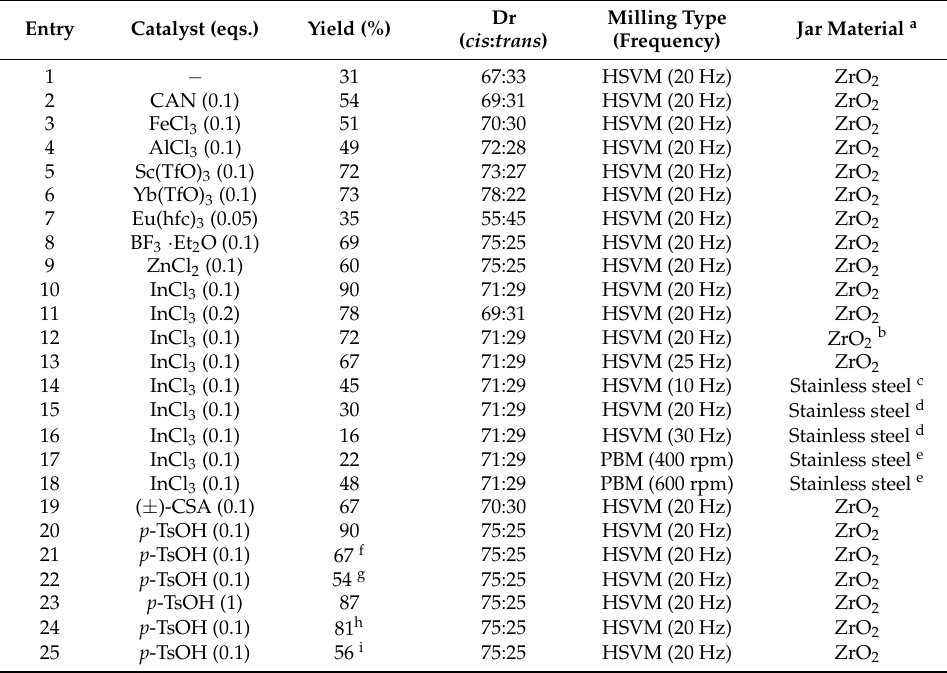
Scheme 2. Model reaction studied during the optimization work. Table 1. Optimization of the synthesis of compound 2a .